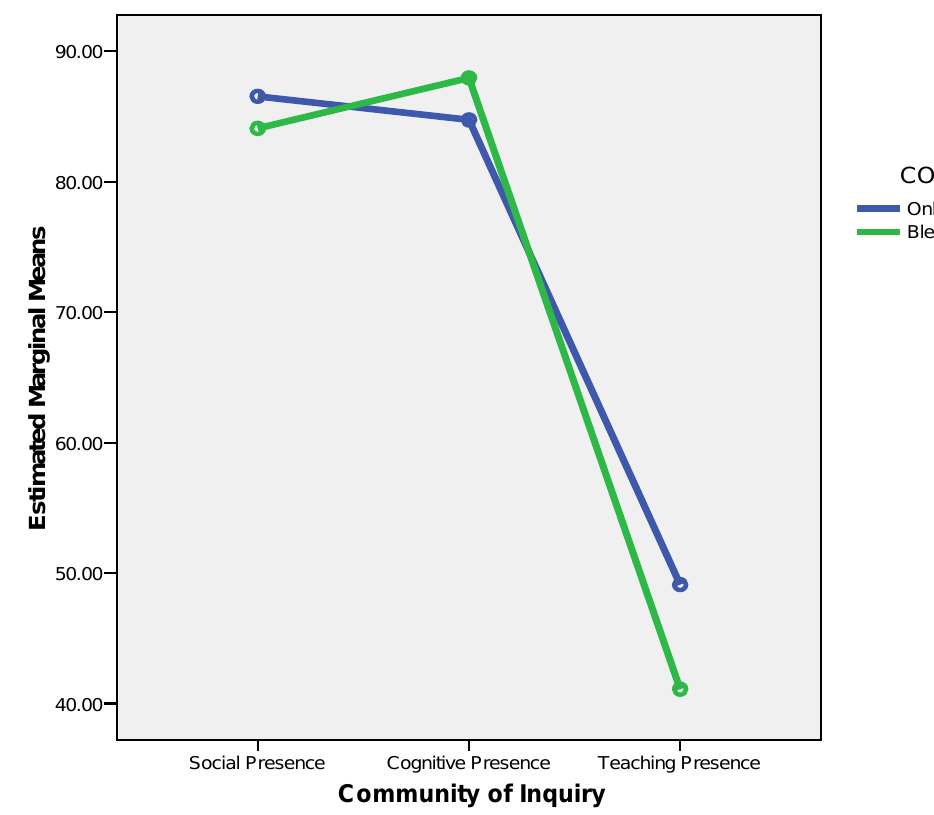
Figure 2. Development of social, cognitive and teaching presence in online and blended course. Social